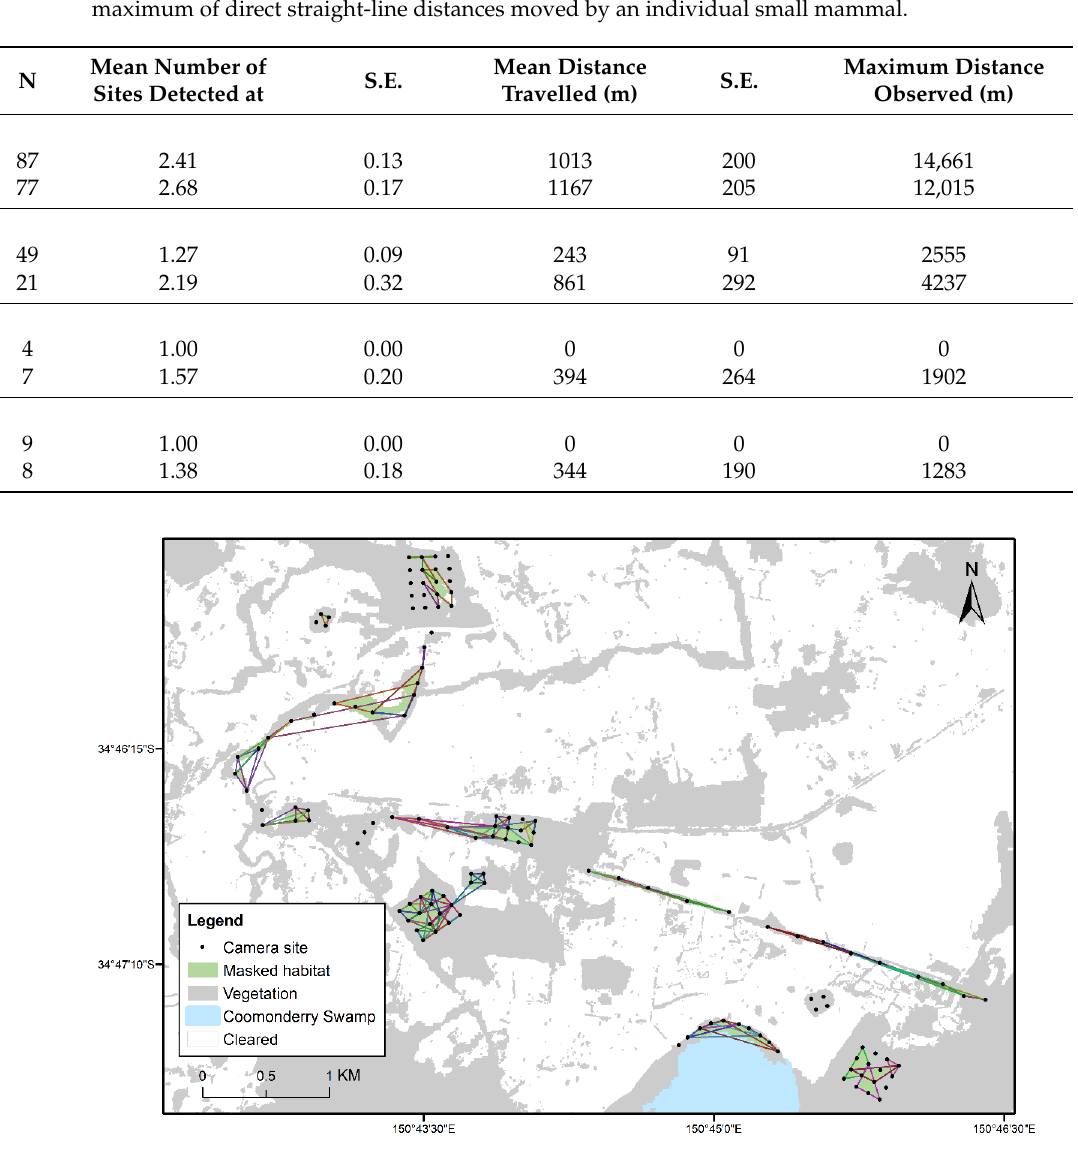
Figure 4. Polygons formed for 121 sugar gliders ( Petaurus breviceps ) where individuals (females = 63, males = 58) were observed on at least two selfie trap sites. Useable habitat within polygons (masked habitat) is highlighted in green.